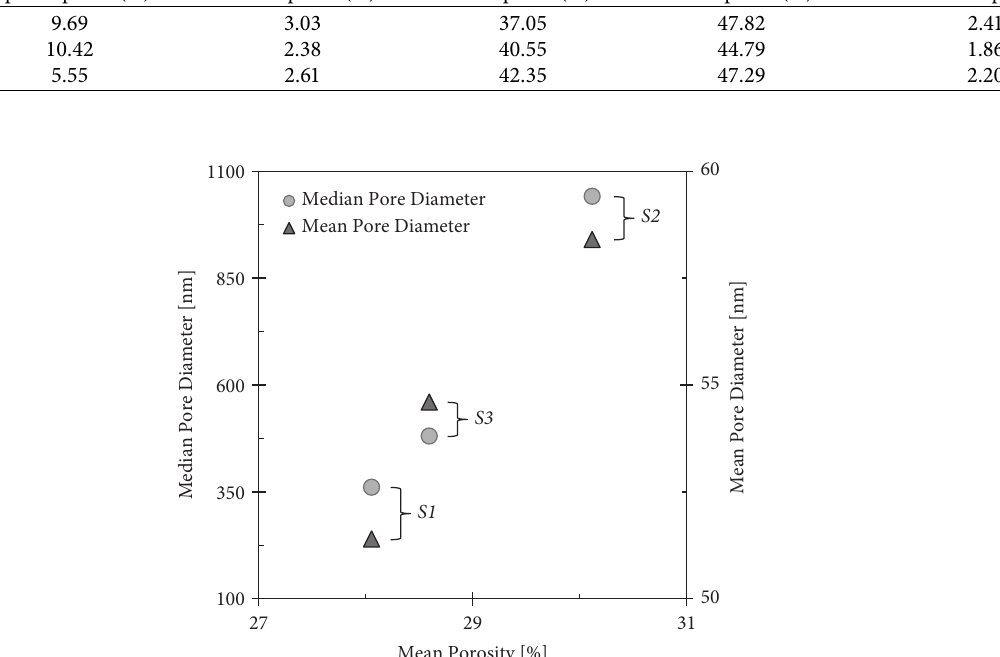
Table 5: The pore volume fraction from the MIP tests for the samples prepared by the three protocols. Sample